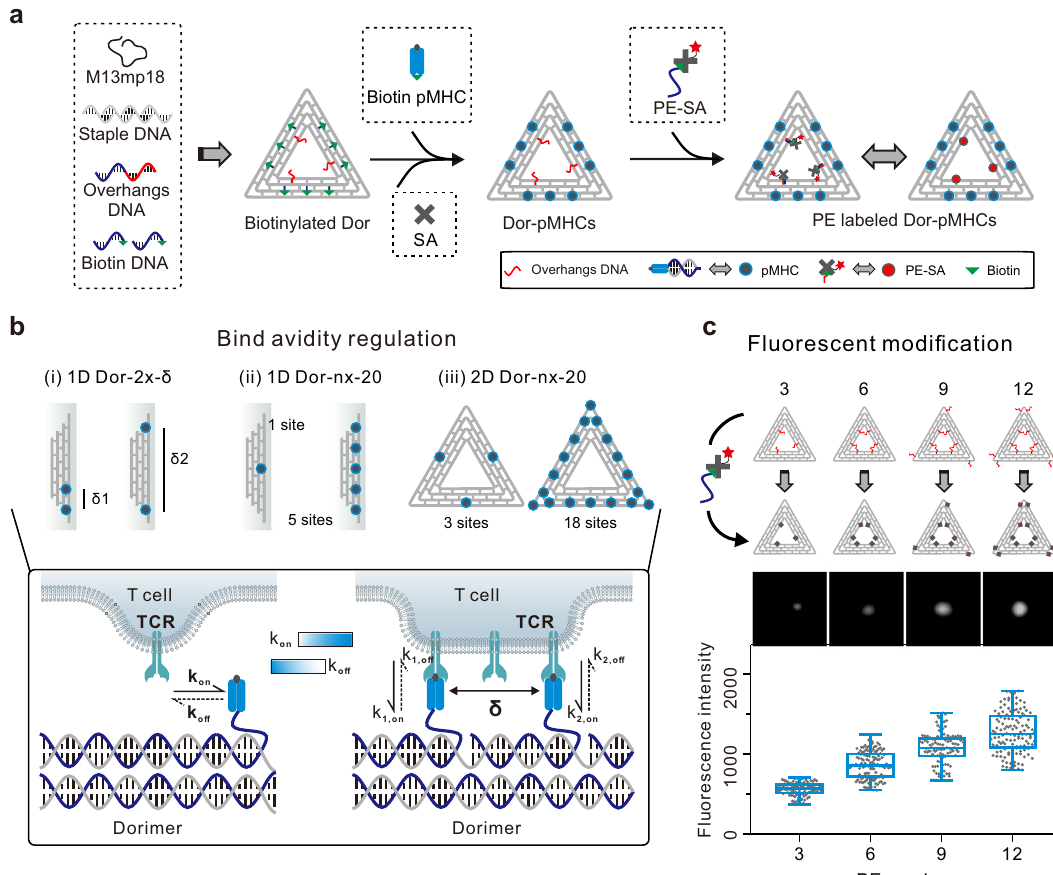
Fig. 1 Nanoscale organization of pMHC molecules with DNA origami. a Schematic illustrating the construction of 2D pMHC multimers with triangular DNA origami scaffolds. Single-stranded M13 phage genomic DNA was mixed with predesigned staple strands (including overhangs-DNA, and biotin-DNA) at the ratio of 1:10 for assembly of the biotinylated DNA origami, where biotins served as SA-binding sites. SA molecules and biotinylated pMHC molecules were successively assembled onto DNA origami based on the biotin – streptavidin interaction, generating Dor-pMHCs. Three pMHC molecules are assembled at each SA-binding site. Poly-A Oligonucleotide-conjugated PE-SA was site-speci fi cally coupled to Dor-pMHCs through hybridization to overhangs-DNA (poly-T oligonucleotides, labeled by red) extended from predesigned locations. b Schematic overview of the determinants that potentially regulate avidity of TCR binding, including (i) the inter-pMHC spacing ( δ : 20 – 80 nm), (ii) 1D ( n : 1 – 5 binding sites) and (iii) 2D ( n : 3 – 18 binding sites) with different pMHC stoichiometry. The constructed Dor-pMHCs were abbreviated as Dor- nx - δ ( n indicates the number of SA-binding site, δ indicates the inter- pMHC spacing on each edge). c The fl uorescence intensity of DNA origami labeled with different numbers of PE proteins (ranging from 3 to 12) and their corresponding fl uorescence images. Red dots indicated PE proteins assembled on DNA origami. Data represent the mean ± largest/smallest. (Data were collected based on about 100 counts of samples: 3, n = 96 particles; 6, n = 133 particles; 9, n = 105 particles; 12, n = 126 particles). Source data are provided as a Source Data fi le. Dor DNA origami, SA streptavidin, pMHC peptide – major histocompatibility complexes, PE-SA phycoerythrin-labeled